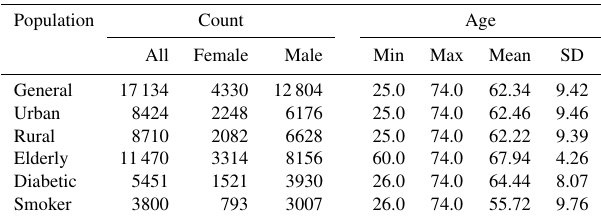
Table 6. Overview of the number of cases as well as age and sex distribution for the different study populations